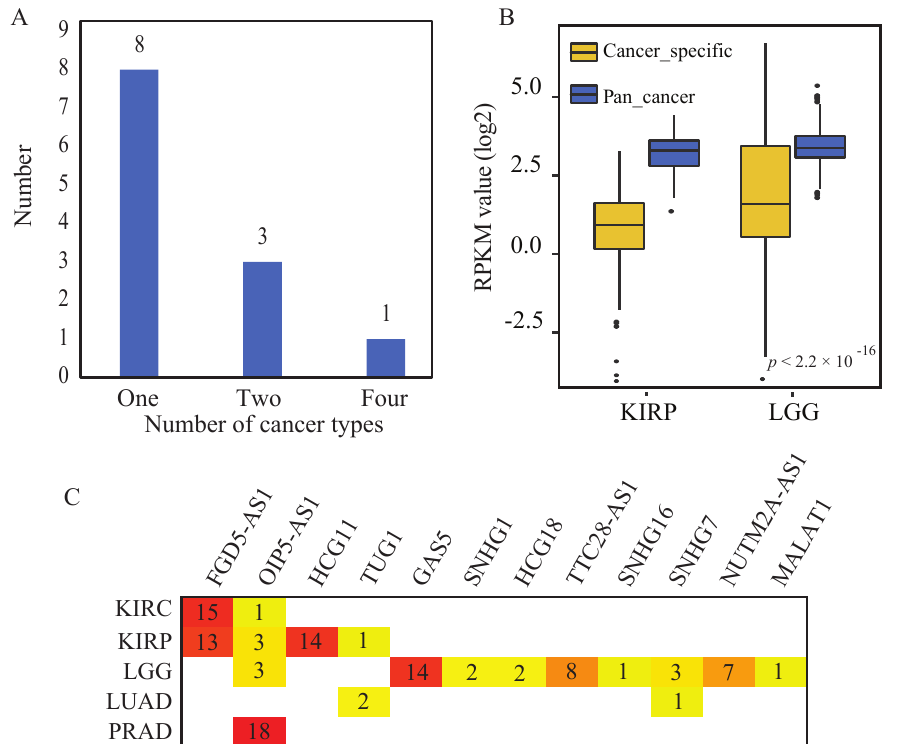
Figure 3. The diversity of lncRNA-perturbated triplets highlight the broad heterogeneity underlying various cancer types. ( A ) The number of lncRNA perturbators that occur in di ff erent number of cancer types. ( B ) The expression level of cancer-specific lncRNA perturbators and pan-cancer lncRNA perturbator (pan-cancer lncRNA perturbator, OIP5-AS1 ; cancer-specific lncRNA perturbators, 1 in KIRP and 7 in LGG). ( C ) The number of mRNAs that perturbated by the lncRNA perturbators in 5 cancer types, with deeper color representing larger numbers of mRNAs. Lower grade glioma, LGG; kidney clear cell carcinoma, KIRC; kidney papillary cell carcinoma, KIRP; lung adenocarcinoma, LUAD; prostate cancer,